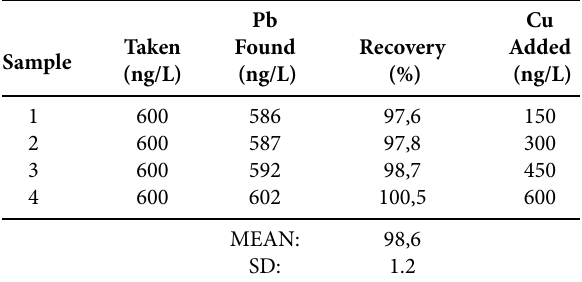
table 4. Results of Cu recoveries obtained with DPASV method in laboratory-made synthetic samples Cu Pb Sample